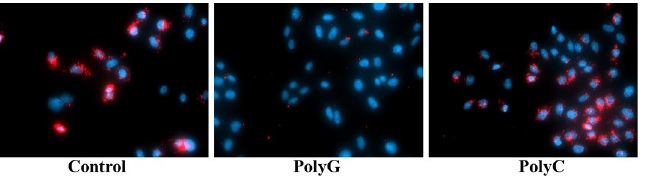
Figure 7. Effects of polyG or polyC on cellular association of exosomes in CHO-MARCO cells. T-REx-CHO- MARCO cells were cultured with tetracycline in a 96-well black plate with clear bottom. The CHO-MARCO cells were precultured with 200 µg/mL polyG or polyC for 30 min. The cells were exposed to red fluorescent exosomes for 4 h in the presence of each compound. See also the legend to Fig. 6 about treatments after